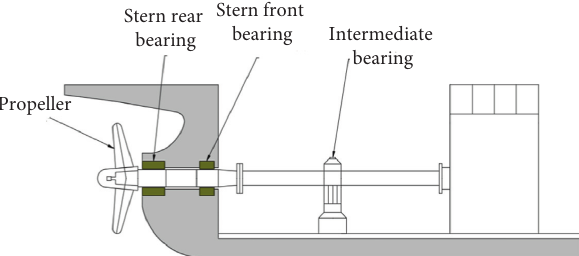
Figure 1: An illustrative model of a ship propulsion shafting system.